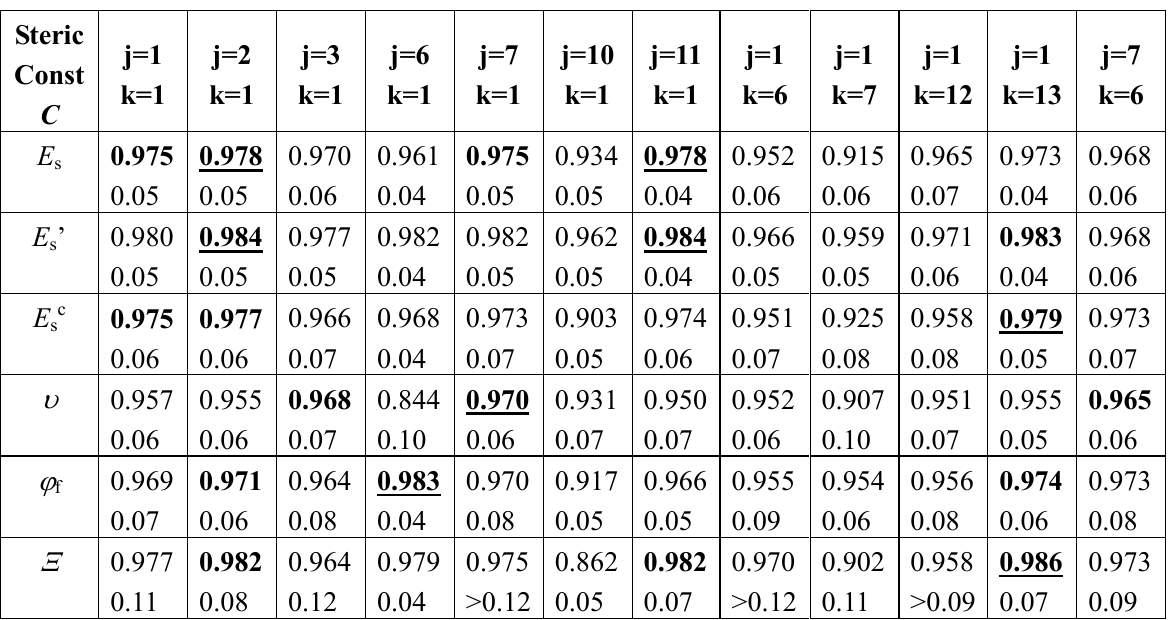
/nm (lower) obtained on c